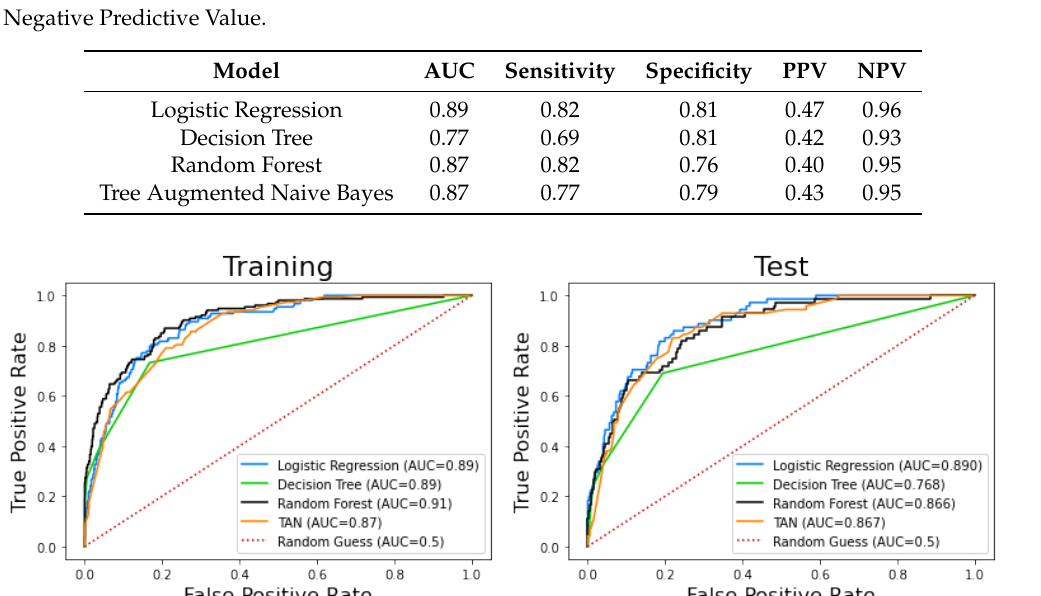
Figure 11. Receiver Operating Curves (ROCs) of the models. ( Left ) Training set. ( Right ) Testing set.